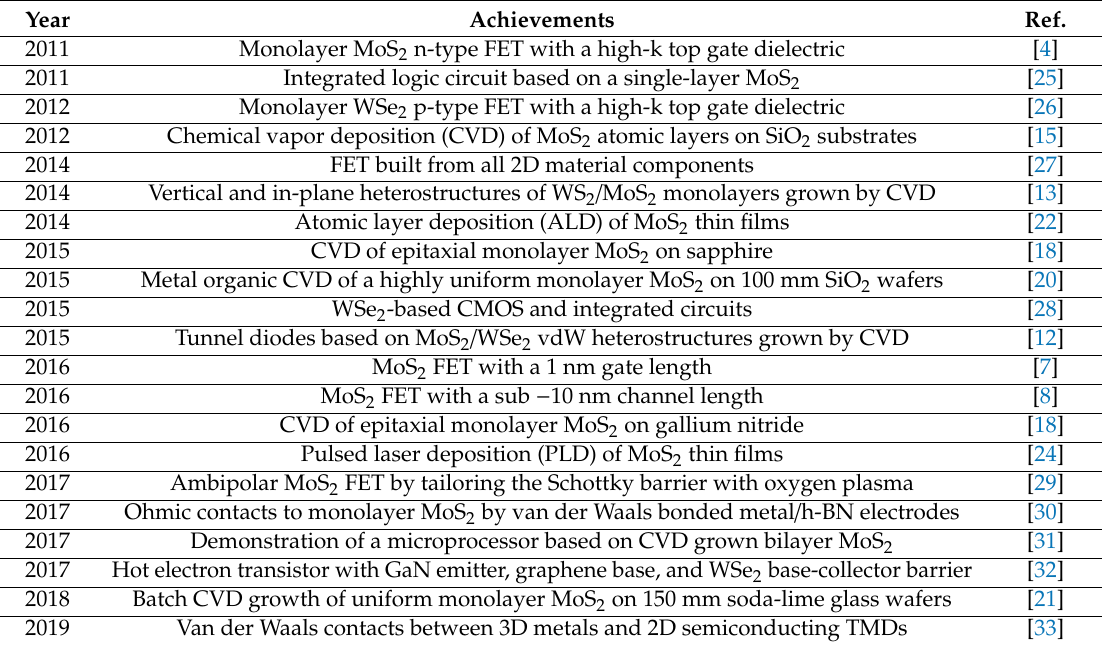
Table 1. Recent progresses in the transition metal dichalcogenide (TMD) materials growth and devices. Year Achievements